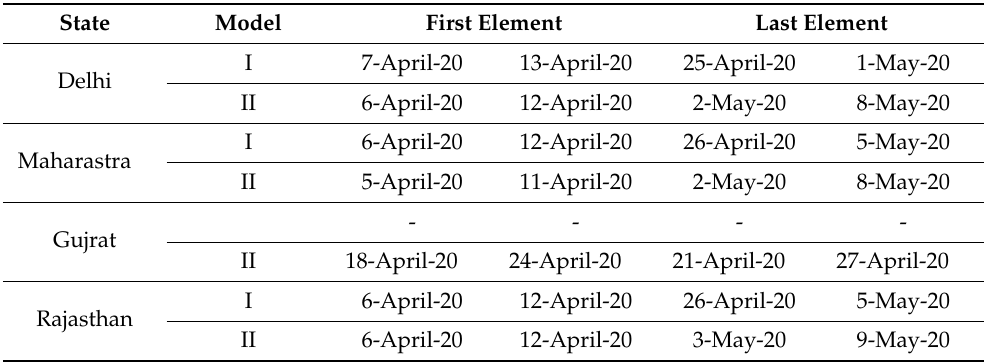
Table 1. Construction of Rolling Grey Models-I and II